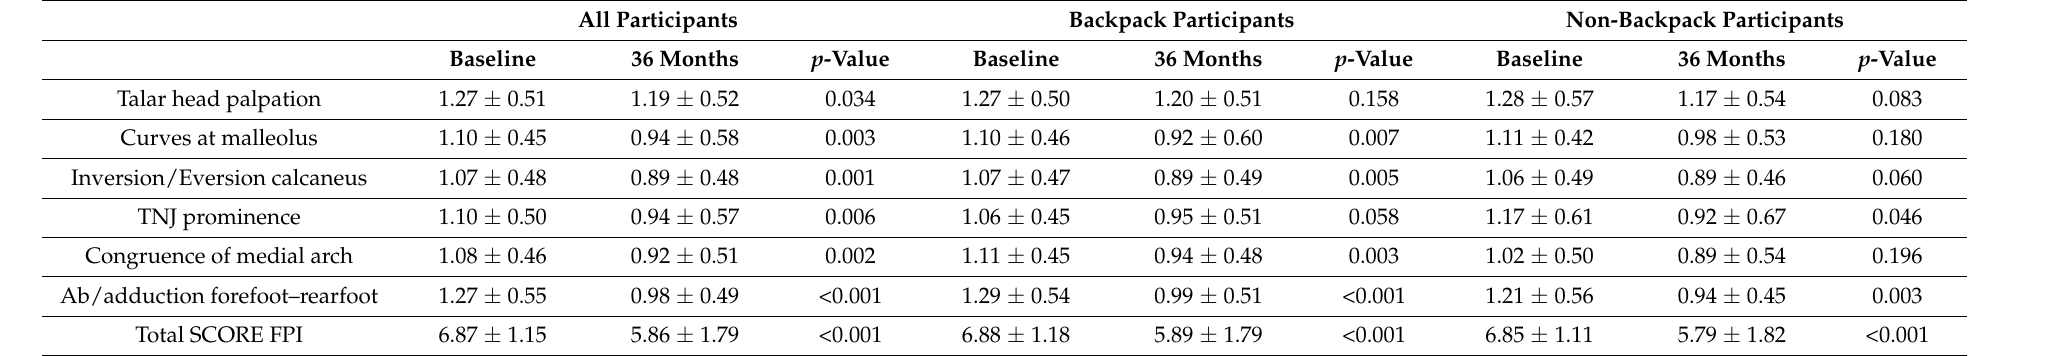
Table 2. Total score for FPI and those for the six criteria stratified by backpack